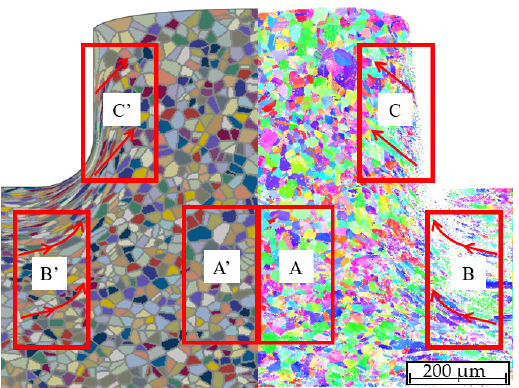
Figure 16. Comparison of microstructure between simulation (left) and experiment (right).